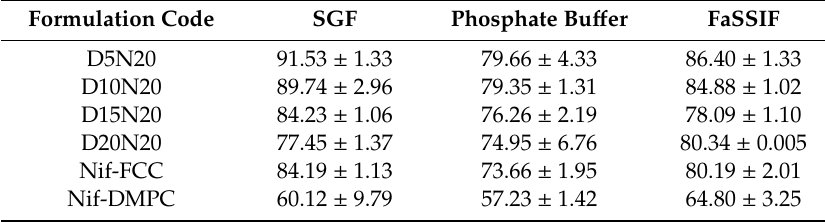
Table 2. Dissolution e ffi ciency of formulations calculated based on Equation (2).